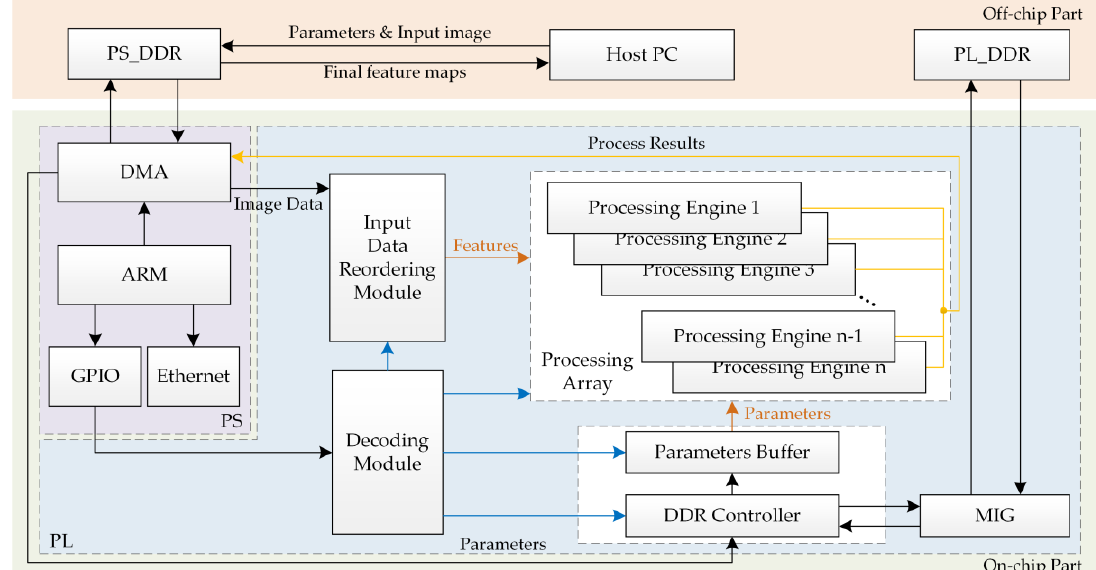
Figure 8. The overall diagram of the proposed hardware